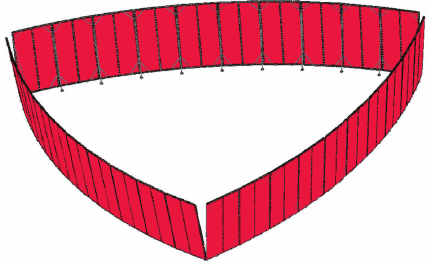
Figure 1: General configuration of